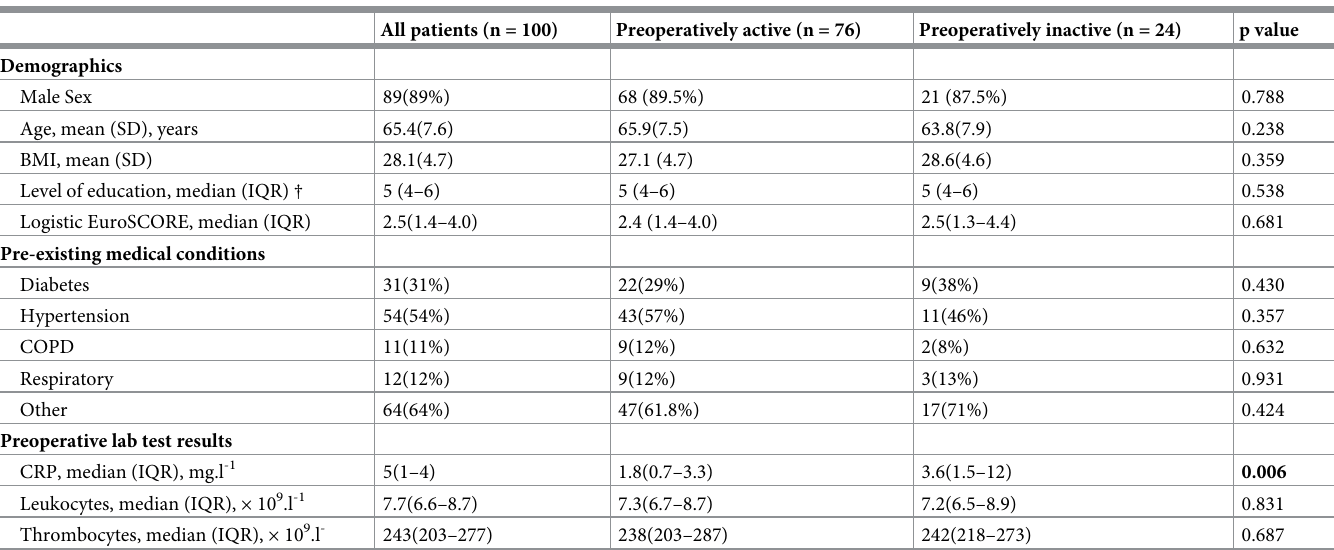
Table 3. Demographic and clinical characteristics of all patients included into the study.